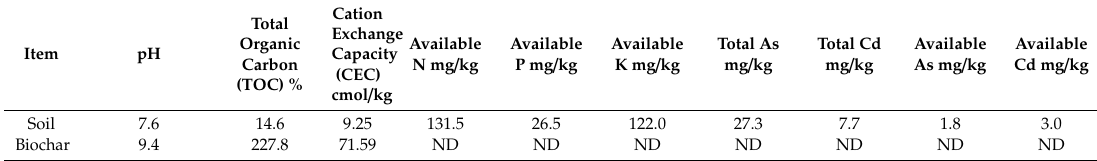
Table 1. Soil and biochar